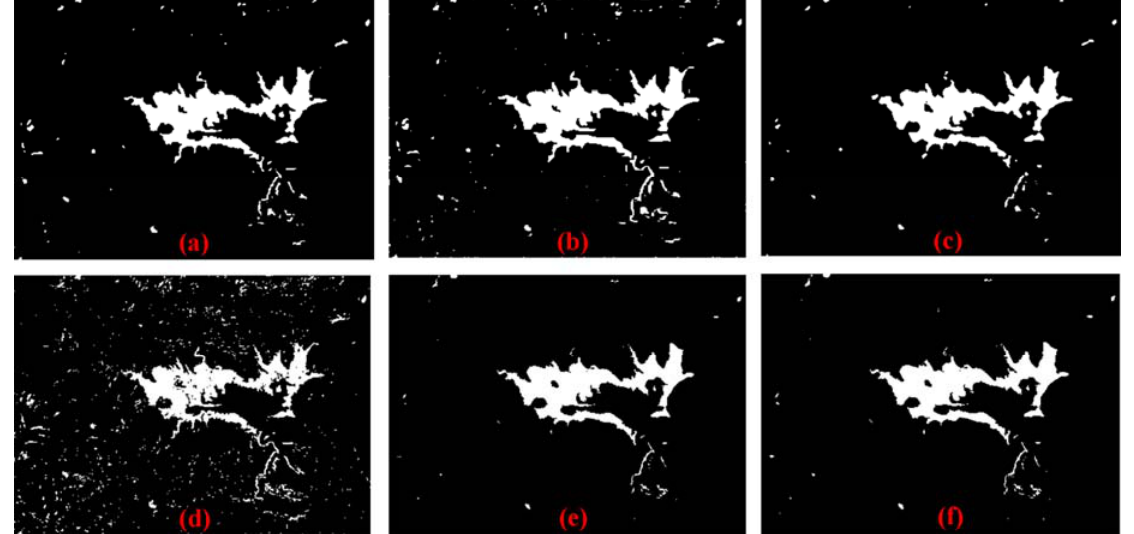
Figure 8. Sardinia Island dataset: Binary change detection map generated by different methods: ( a ) LSELUC [45]; ( b ) MLS [46]; ( c ) PCA_Kmeans [43]; ( d ) CVA [36]; ( e , f ) the proposed approach with Otsu binary threshold and manual threshold, respectively.